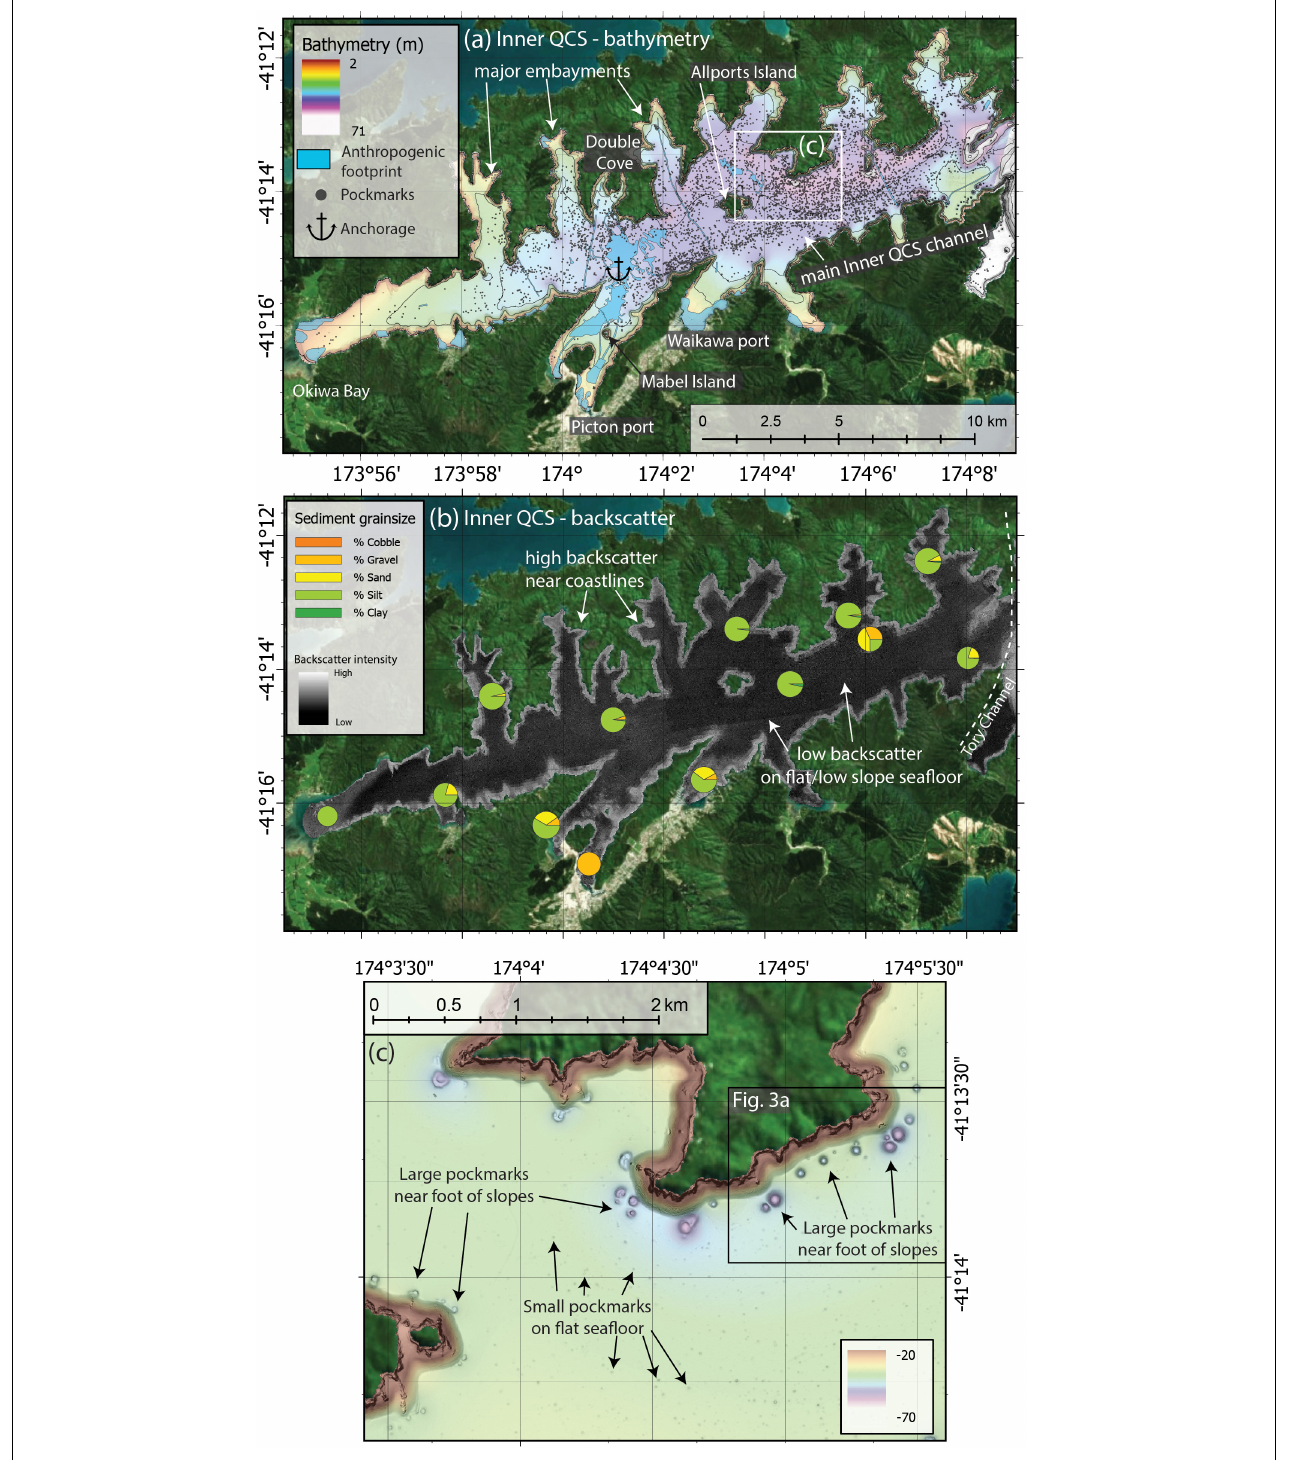
FIGURE 2 | (a) Gridded 2-m bathymetry overview of the inner QCS. For location of inner QCS see Figure 1b . Features described in the main text are labeled. Blue transparent polygons are seafloor regions affected by anthropogenic activities, black points are locations of pockmarks, black lines are bathymetric contours at 10 m intervals. Anchor symbol represents the location of the Picton Anchorage. White square shows location of inset (c). (b) Gridded 0.5 m seafloor backscatter mosaic in the inner QCS. For clarity, pie charts show a subset of sample grain-size distributions that are representative of the trends observed in the complete dataset (for locations and grainsize distribution data for all samples collected in the HS51 project, refer to Supplementary Material 1 ). (c) Zoomed in view of small and large pockmarks and their typical spatial distributions. For image location see inset a. Black rectangle shows the location of Figure 3a .